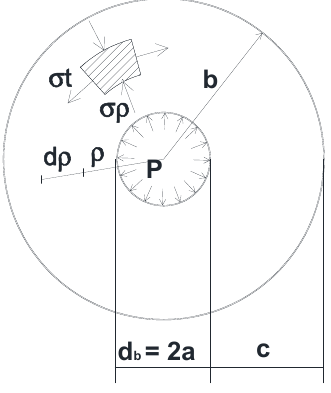
Figure 13. Concrete cylinder concentrically reinforced with FRP